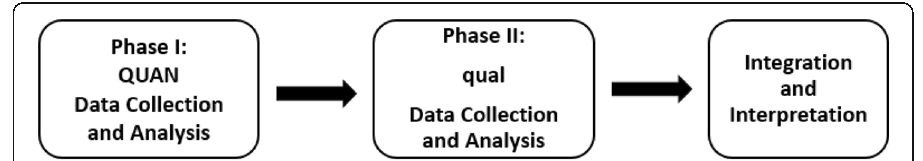
Fig. 1 Visual representation of the explanatory sequential mixed methods